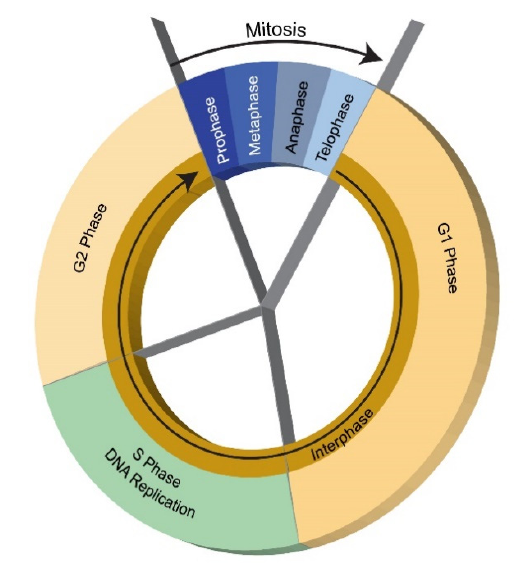
Figure 5. Cell cycle (credit National Institute of Health).